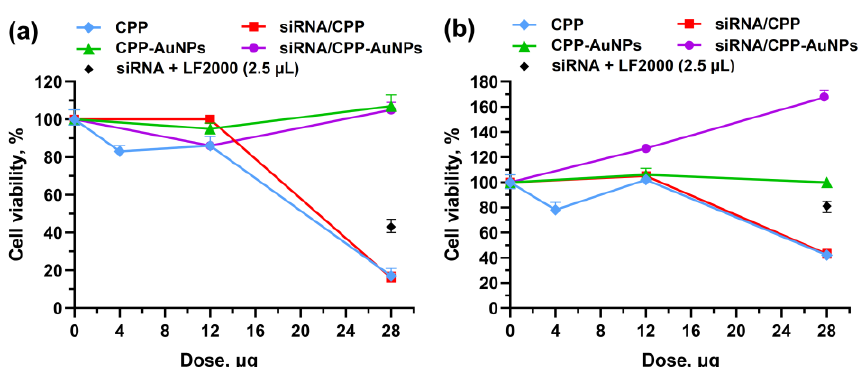
Figure 5. Cell viability (% of that of untreated cells) 48 h after treatment with CPP, CPP-AuNP, siRNA/CPP, siRNA/CPP-AuNP, and siRNA/LF 2000 in: ( a ) serum-free medium (Opti-MEM) and ( b ) serum-containing medium (DMEM/F-12). The doses indicate: for CPP treatment—added CPP mass, in other cases—added AuNPs mass. For statistical analysis, see Tables S3 and S4.